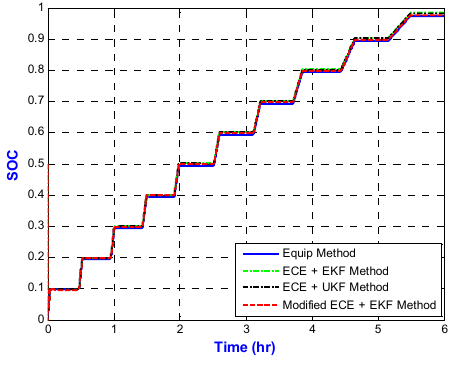
Figure 16. SOC estimation under charge in Experiment II.